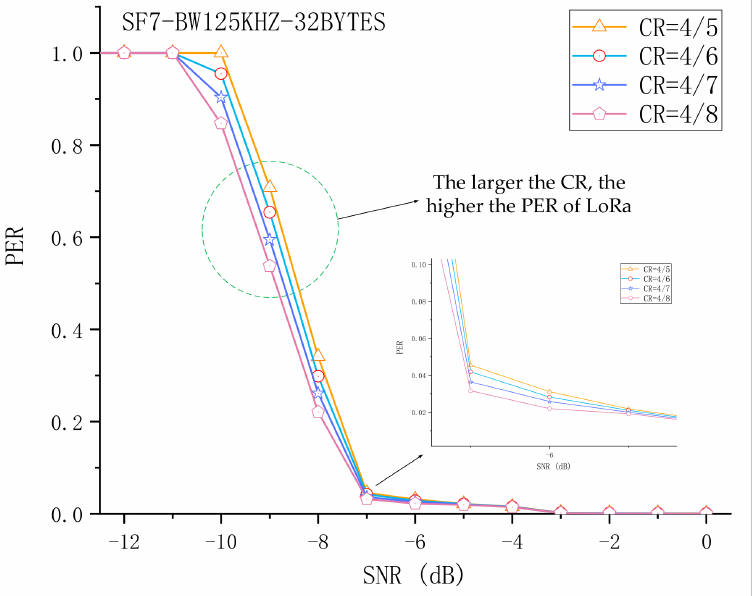
Figure 8. Experimental evaluation of the impact of CR on the packet reception performance of